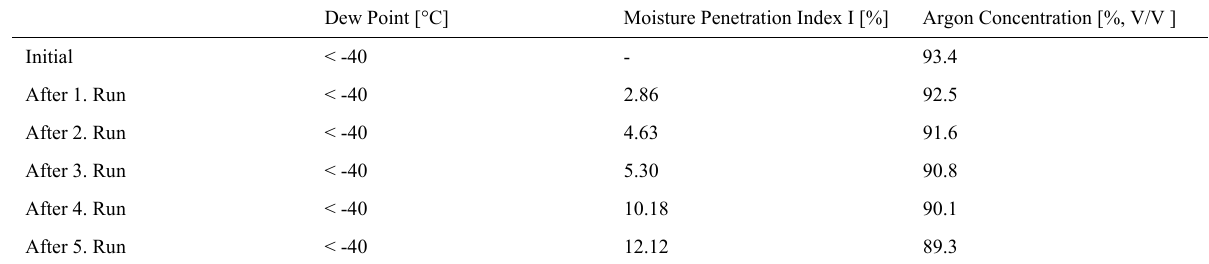
Table 6: Test Results after multiple cycling acc. EN1279